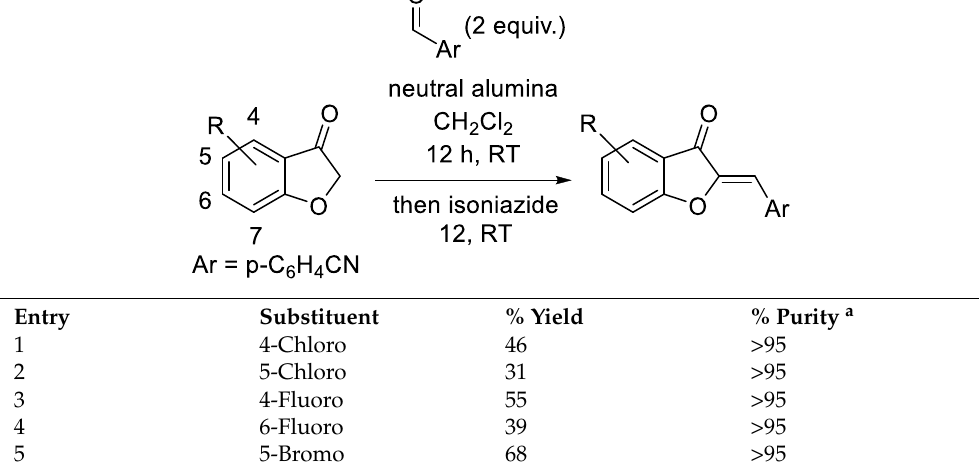
Table 4. Carbonyl’s reactivity with